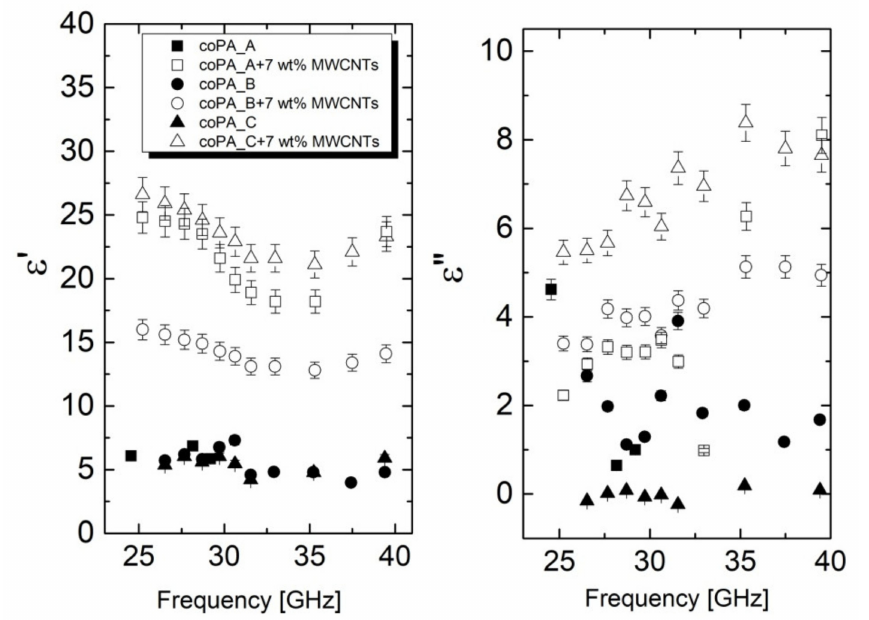
Figure 5. Frequency dependence of complex dielectric permittivity for copolyamide-based fibers with and without MWCNTs. The fibers for the analysis had a similar diameter of around 100 µ